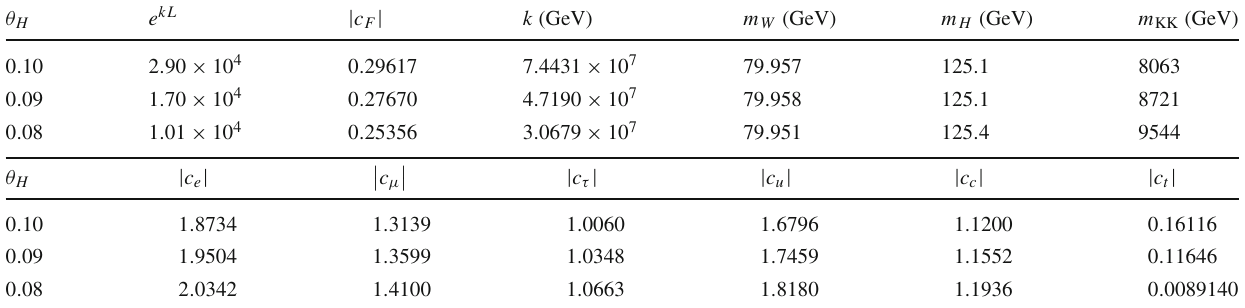
Table 2 The warp factor, the bulk mass parameters of the fermion and AdS curvature with each values of θ H are listed. The resultant W -boson mass, Higgs boson mass and KK scale given from the model parameters are also summarized